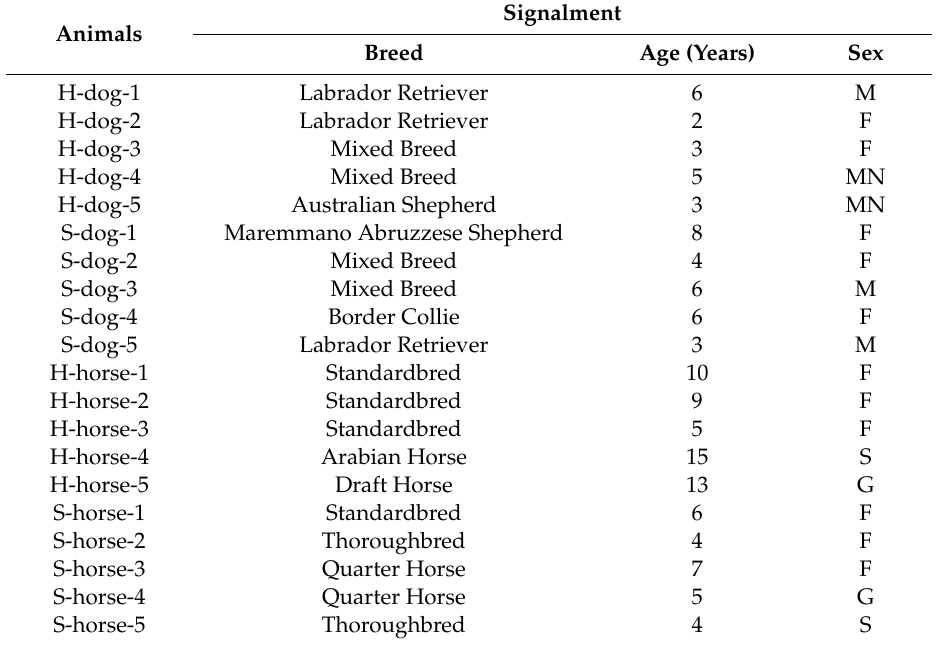
Table 1. Details about signalment for the 20 animals studied (5 healthy and 5 sick dogs; 5 healthy and 5 sick horses). Legend: H—healthy; S—sick; F—female; M—male; MN—male neutered; G—gelding; S—stallion.